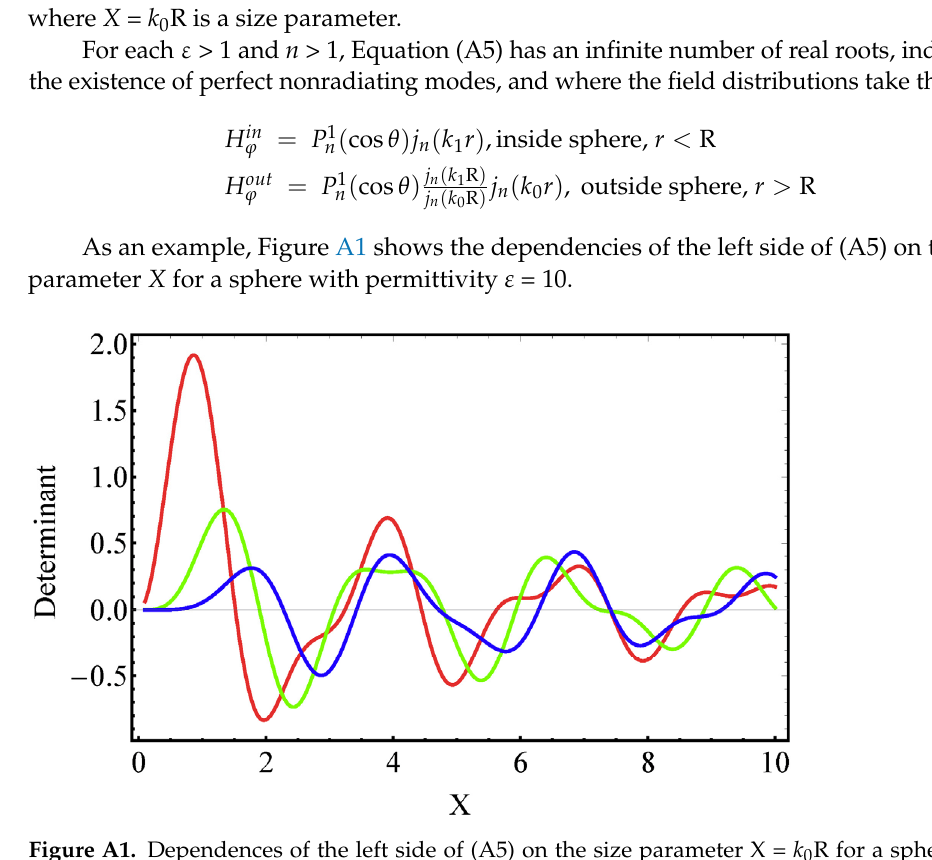
Figure A1. Dependences of the left side of (A5) on the size parameter X = k 0 R for a sphere with permittivity ε = 10 for n = 1 (red), n = 2 (green), and n = 3 (blue).